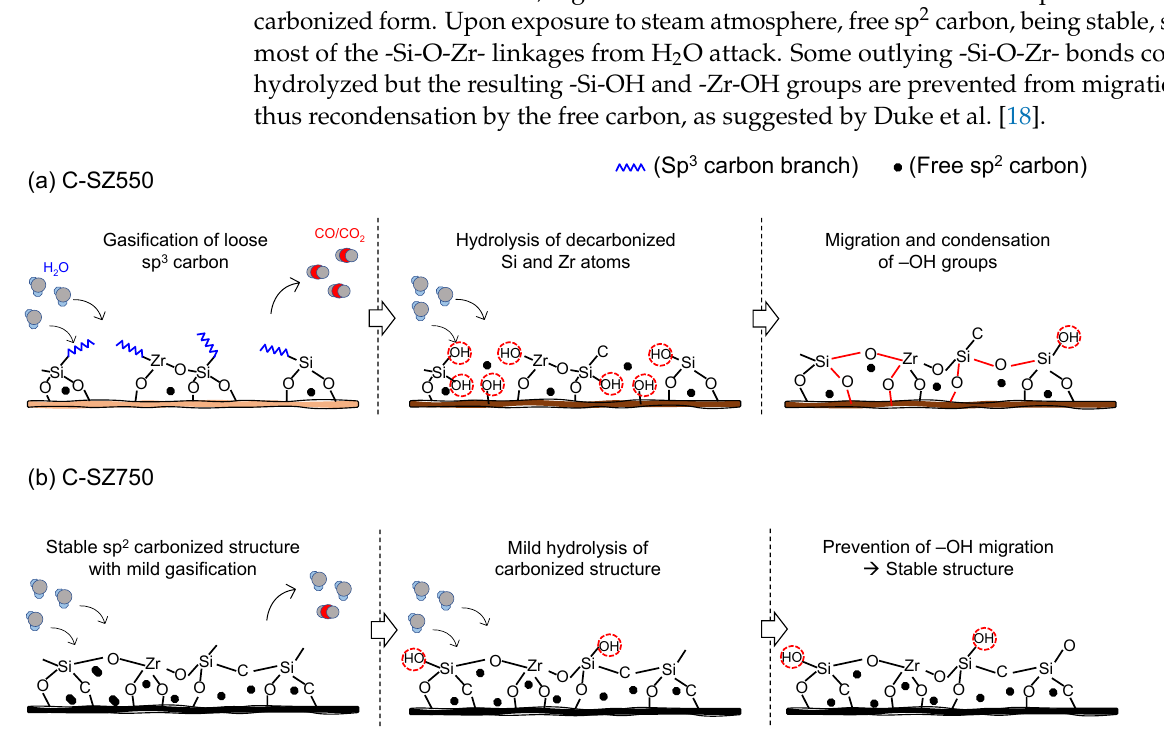
Figure 13. Schematic illustration of the role of fabrication temperature in the microstructural stability of carbon-SiO 2 -ZrO 2 membranes fabricated at ( a ) 550 and ( b ) 750 ◦ C upon exposure to steam. Yoshida et al. [47] investigated the hydrothermal stability of several unmodified SiO 2 -ZrO 2 membranes. While a SiO 2 -ZrO 2 membrane with a silica-to-zirconia ratio of 9/1 showed the best balance of hydrothermal stability and H 2 /N 2 selectivity at 500 ◦ C and 100 kPa partial pressure of steam, the pore size distribution of the membrane changed considerably as hydrothermal exposure increased. The selectivity of H 2 over N 2 increased but the permeance of all gases reduced considerably and the membrane assumed a bimodal pore size distribution. Ahn et al. [48] also tested the hydrothermal stability of an unmodified SiO 2 -ZrO 2 membrane (10% ZrO 2 ) at 650 ◦ C under a steam partial pressure of 101 kPa.